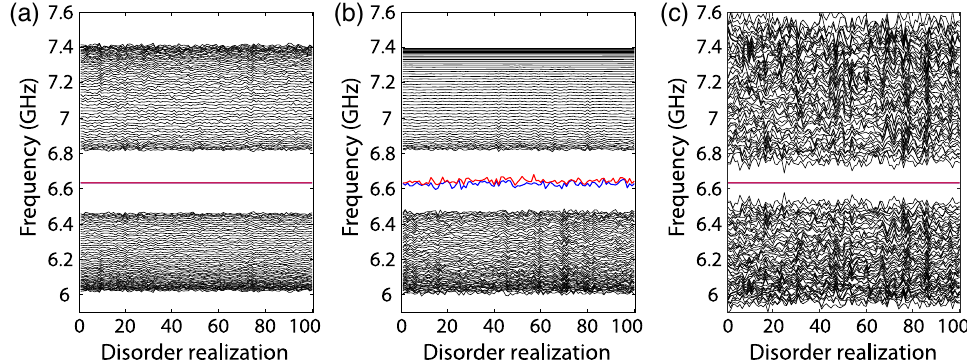
FIG. 8. Eigenfrequencies of the system under 100 disorder realizations in coupling elements. Each disorder realization is achieved by uniformly sampling the parameters within fraction (cid:4) r of the original value. (a) Disorder in mutual inductance M neighboring resonators with the strength r ¼ 0 . 5 . (b) Disorder in coupling capacitance C the strength r ¼ 0 . 1 . (c) The same disorder as (b) with r ¼ 0 . 5 , while keeping the bare self-capacitance C Σ of each resonator fixed (correlated disorder between coupling capacitances and resonator C 0